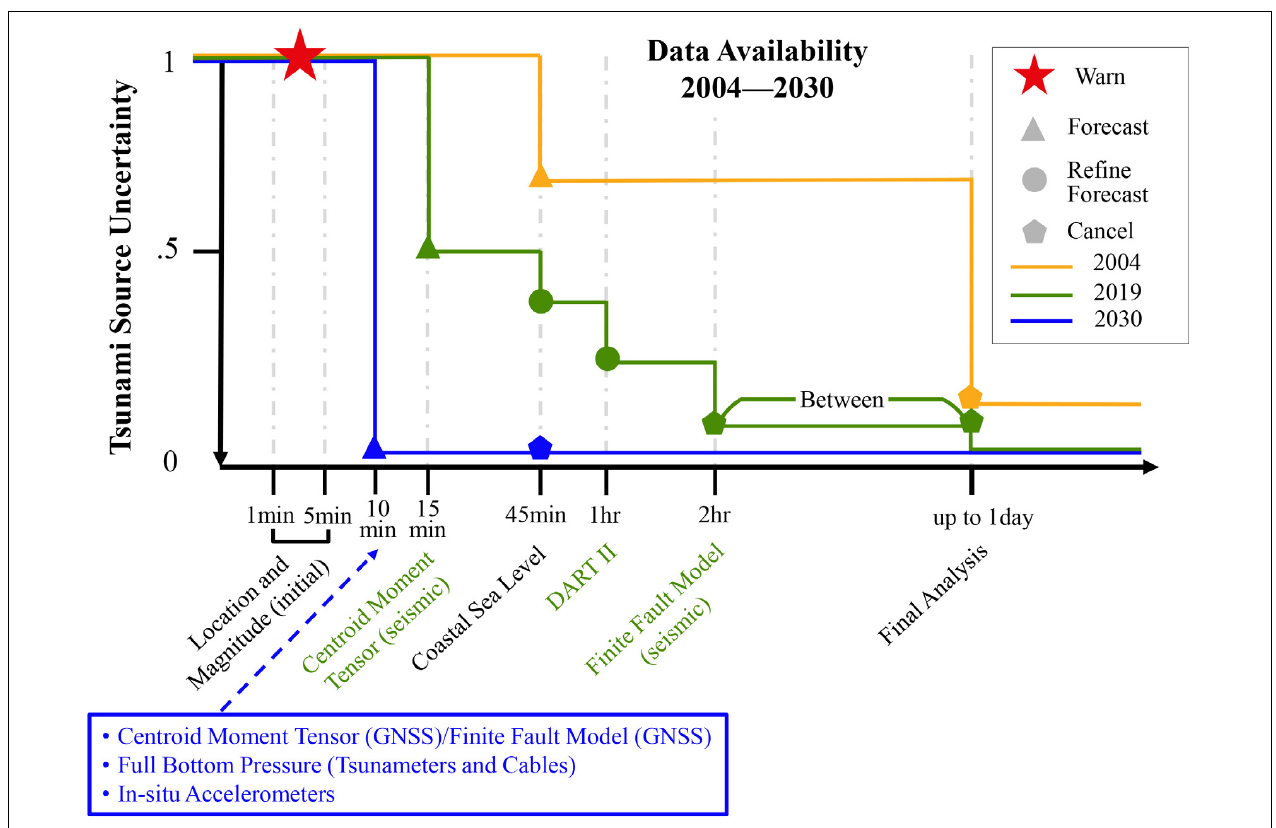
FIGURE 1 | Generalized relationship between tsunami source uncertainty and time after earthquake origin for three different time frames. The orange line represents tsunami source uncertainty levels prior to 2004, the green line represents tsunami source uncertainty levels at present (2019), and the blue line represents tsunami source uncertainty levels achievable with the ocean sensing and analysis techniques advocated for in this paper. Initial earthquake location and magnitude is considered “fully uncertain” in terms of solving tsunami source parameters for the purposes of this